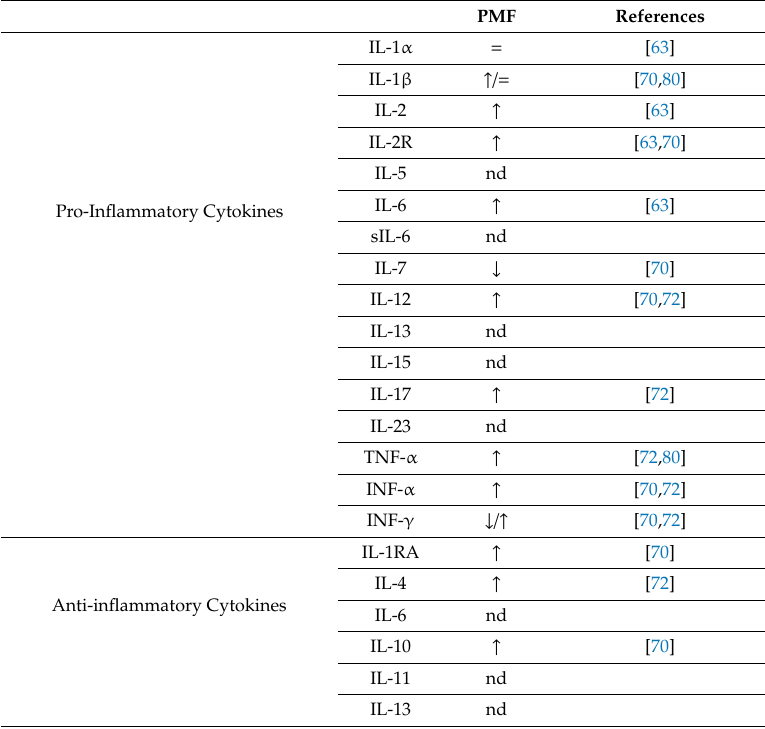
Table 2. Cytokine expression profile in PMF vs. PV /